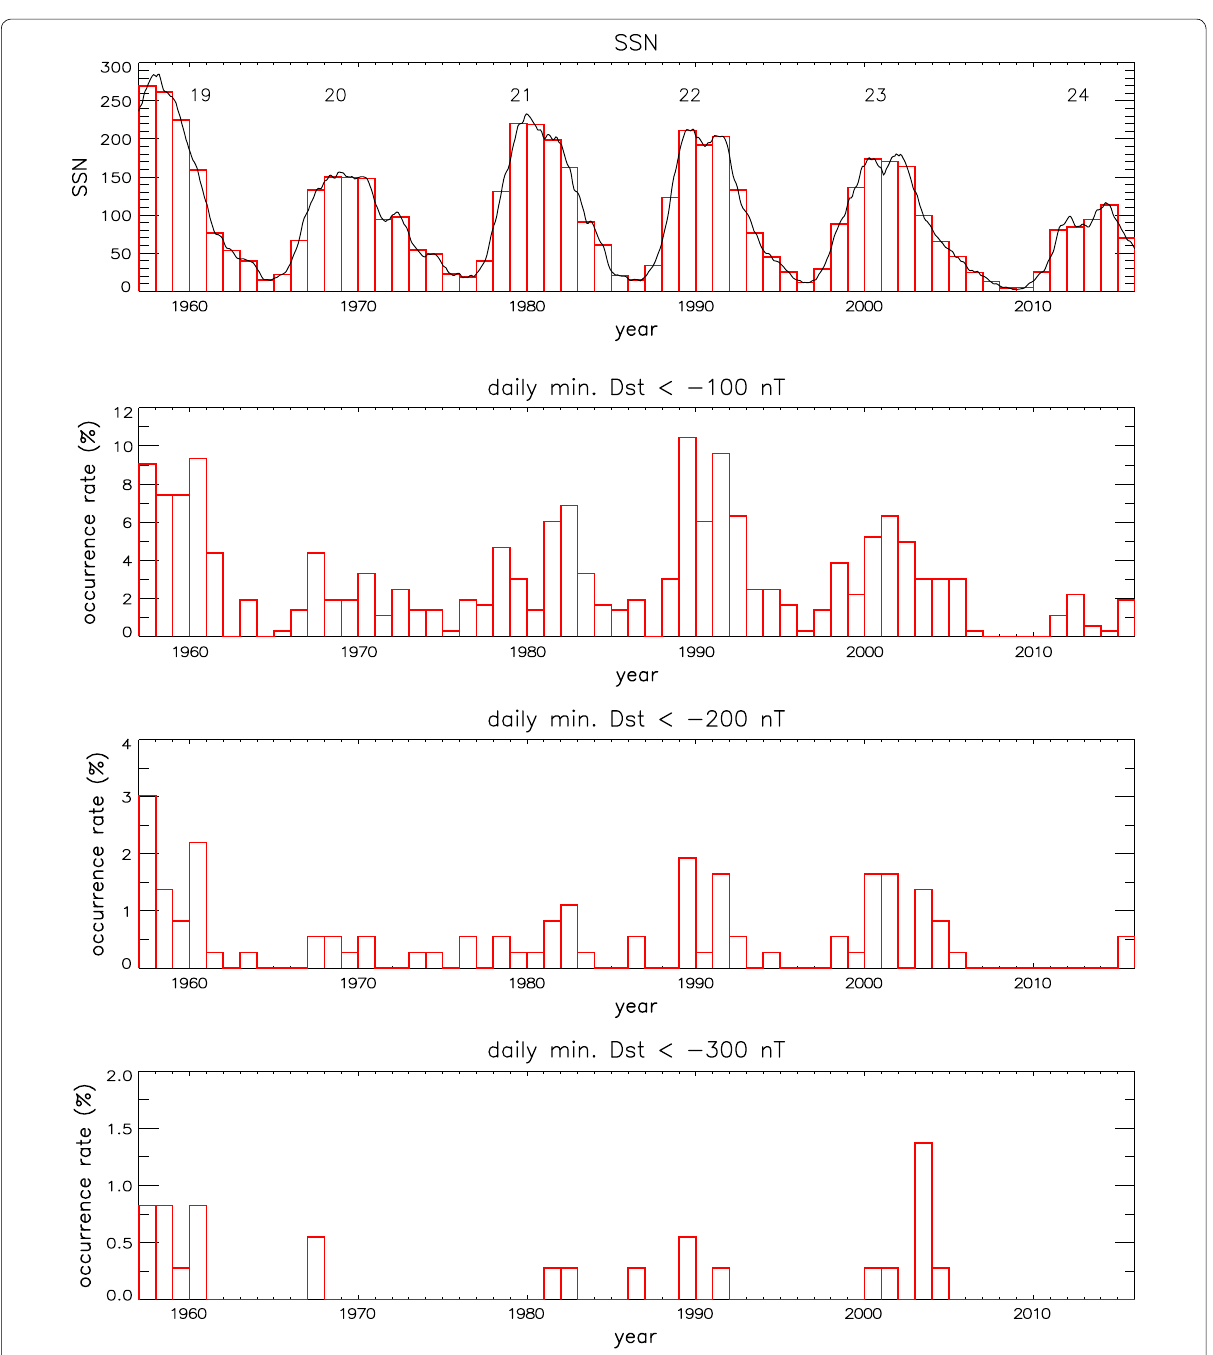
Fig. 1 Top panel is the yearly SSNs ( red line ) with the 13-month smoothed monthly SSNs ( black line ). The second , third , fourth panels show yearly occurrence rates of the daily minimum Dst of less than